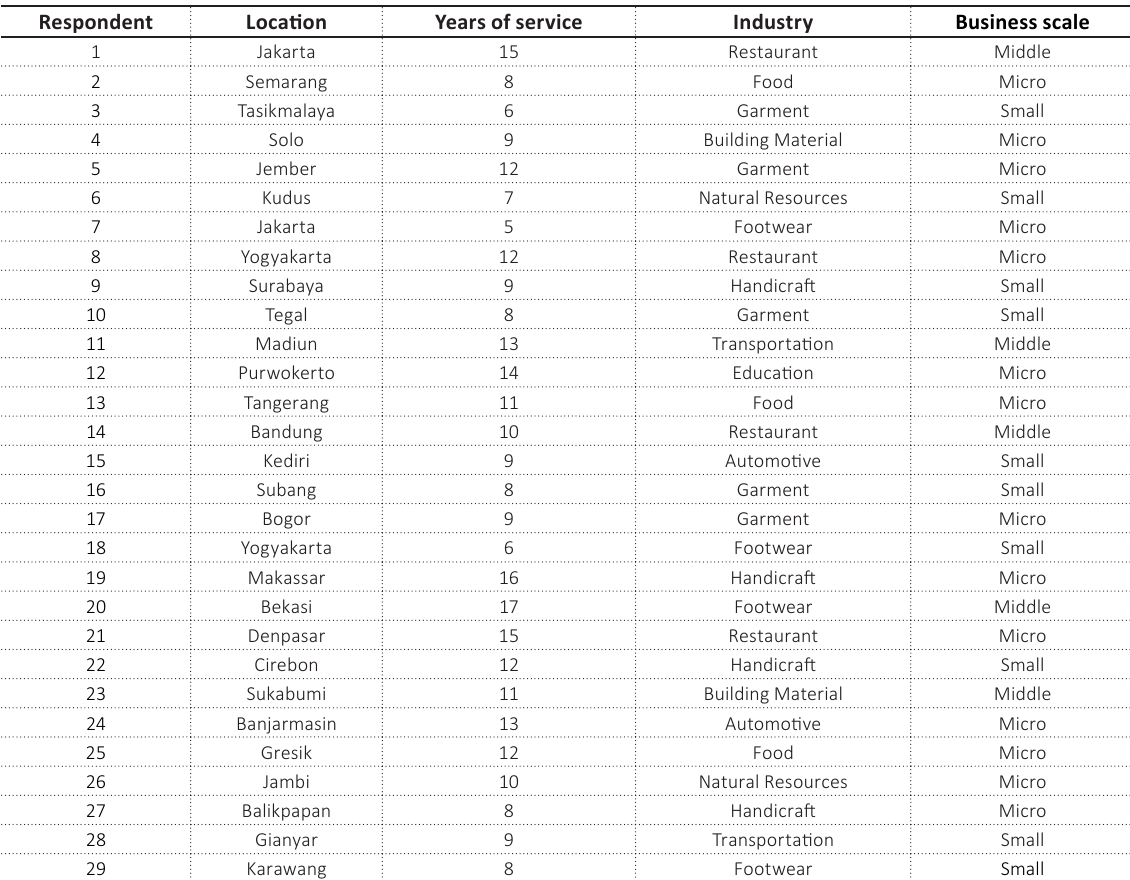
Table 2. Profile of participated MSMEs